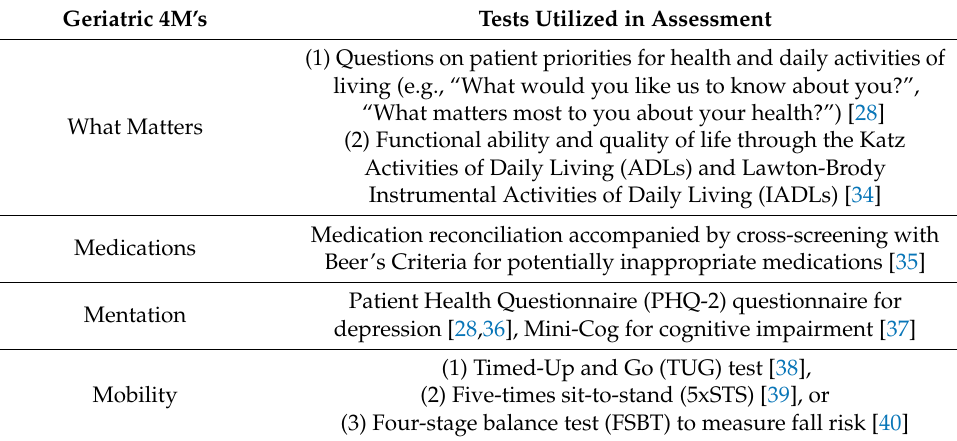
Table 1. Assessments during HATS visit as aligned with Geriatric